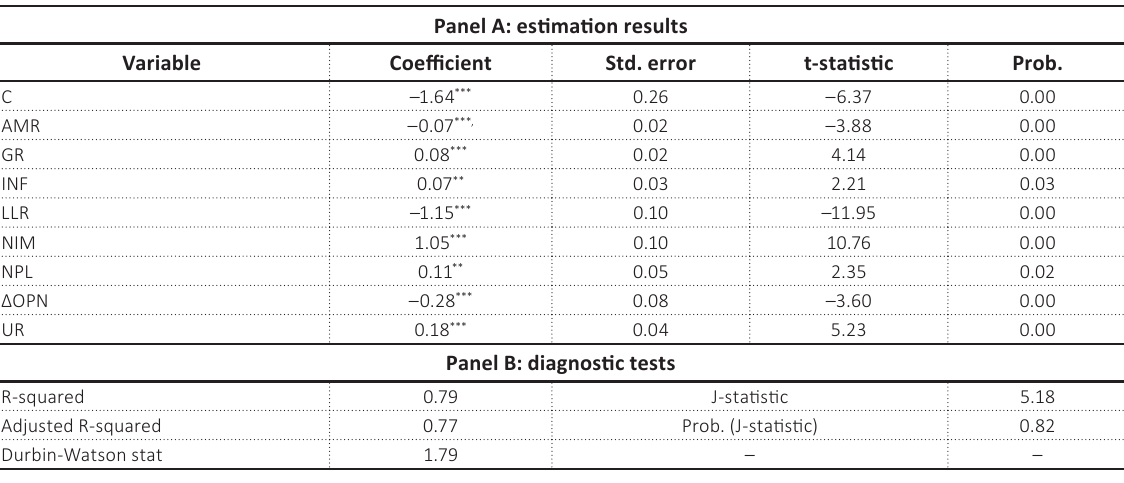
Table 4. GMM estimation results (dependent variable: